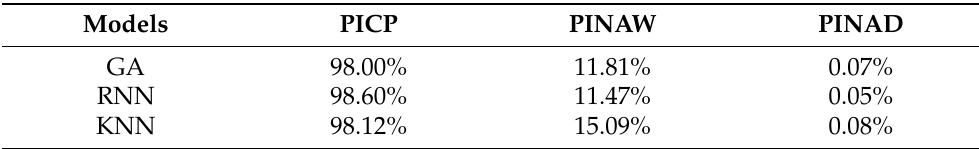
Table 6. Comparative analysis of the best models with the confidence interval (CI) ( PICP, PINAW and PINAD) at 95%.